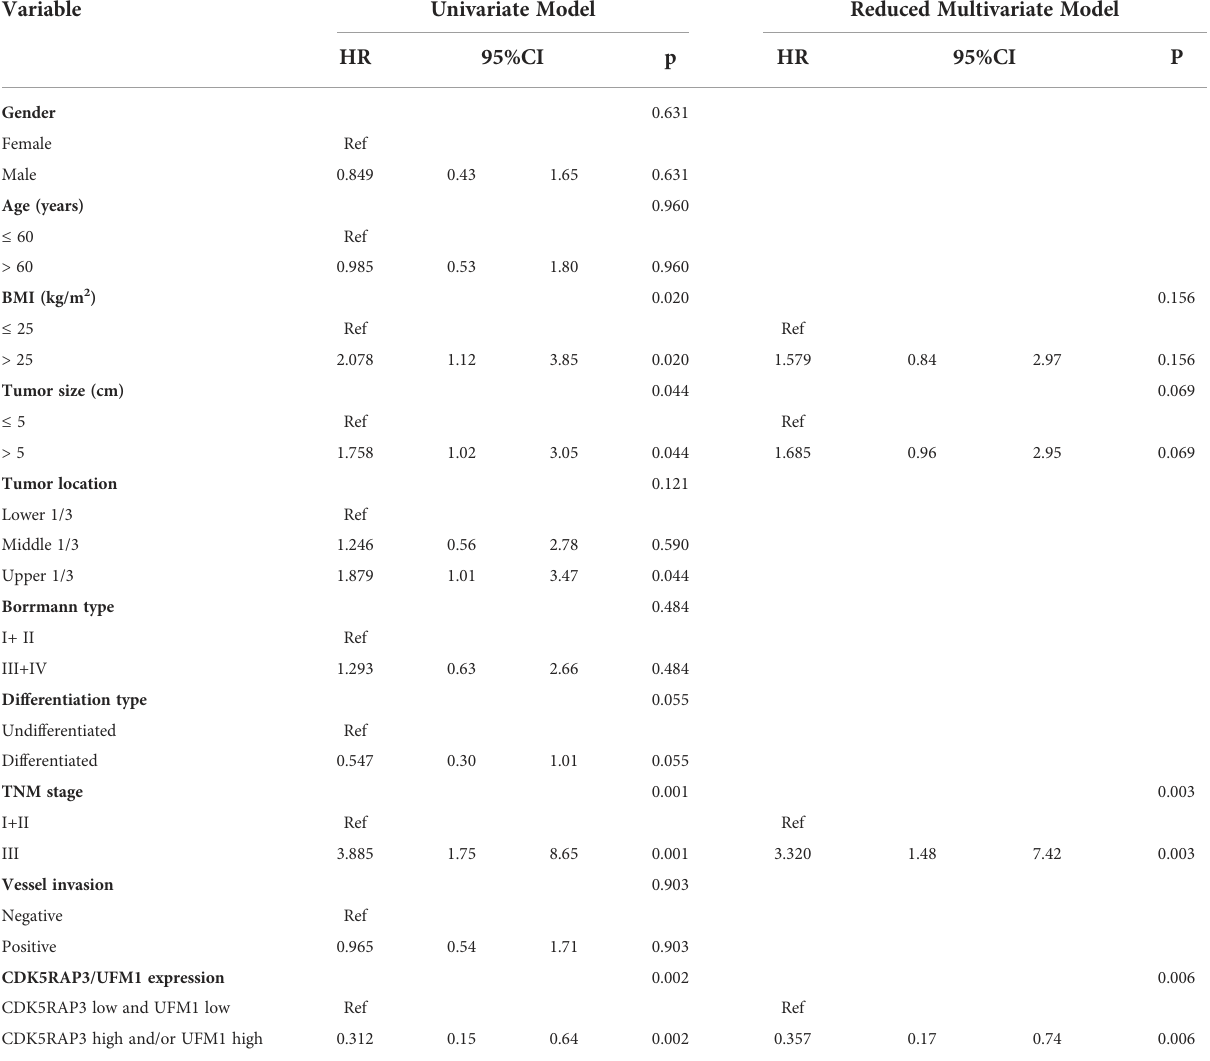
TABLE 3 Cox regression analysis of prognostic factor for gastric